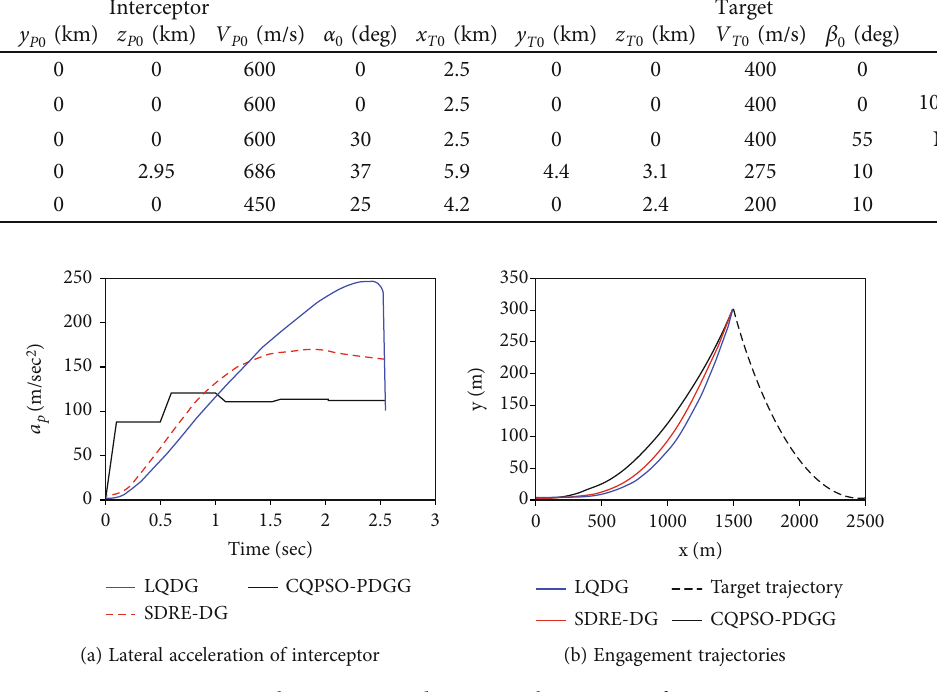
Figure 9: Comparison with SDRE-DG and LQDG in the presence of step target